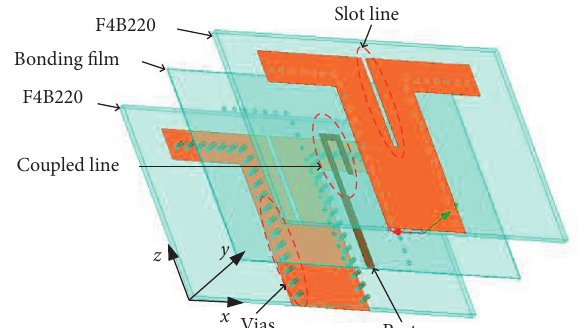
Figure 2: Exploded view of the dipole unit cell.